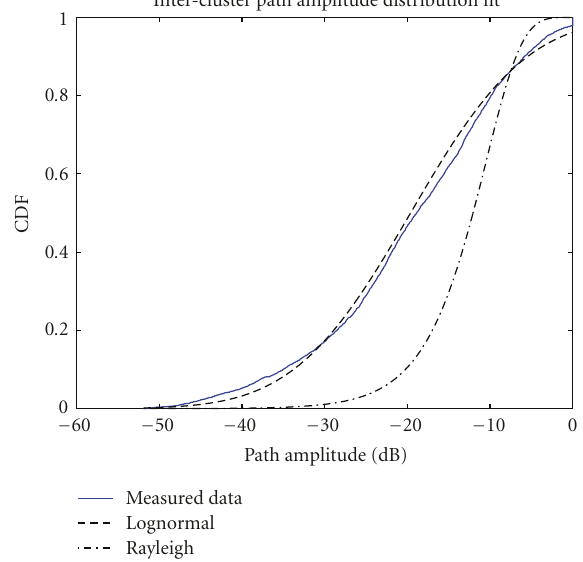
Figure 15: Intra-cluster path amplitudes CDF with the best-fit Rayleigh (RMSE = 0.2357) and lognormal (RMSE = 0.0239) distri- butions for measurements inside the Taurus engine